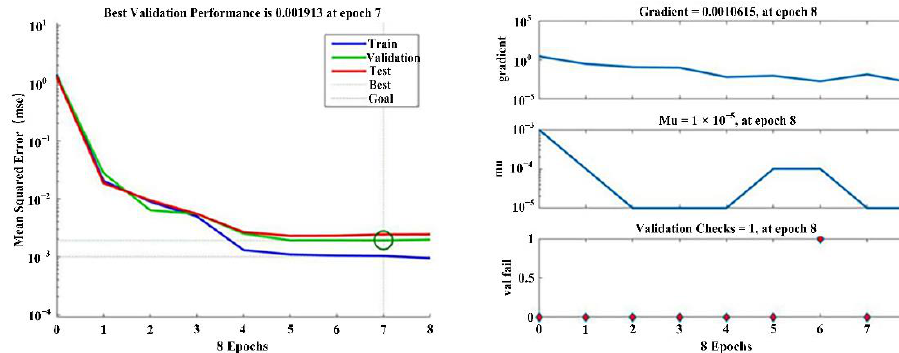
Figure 2. Training error curve of the SWQM model.